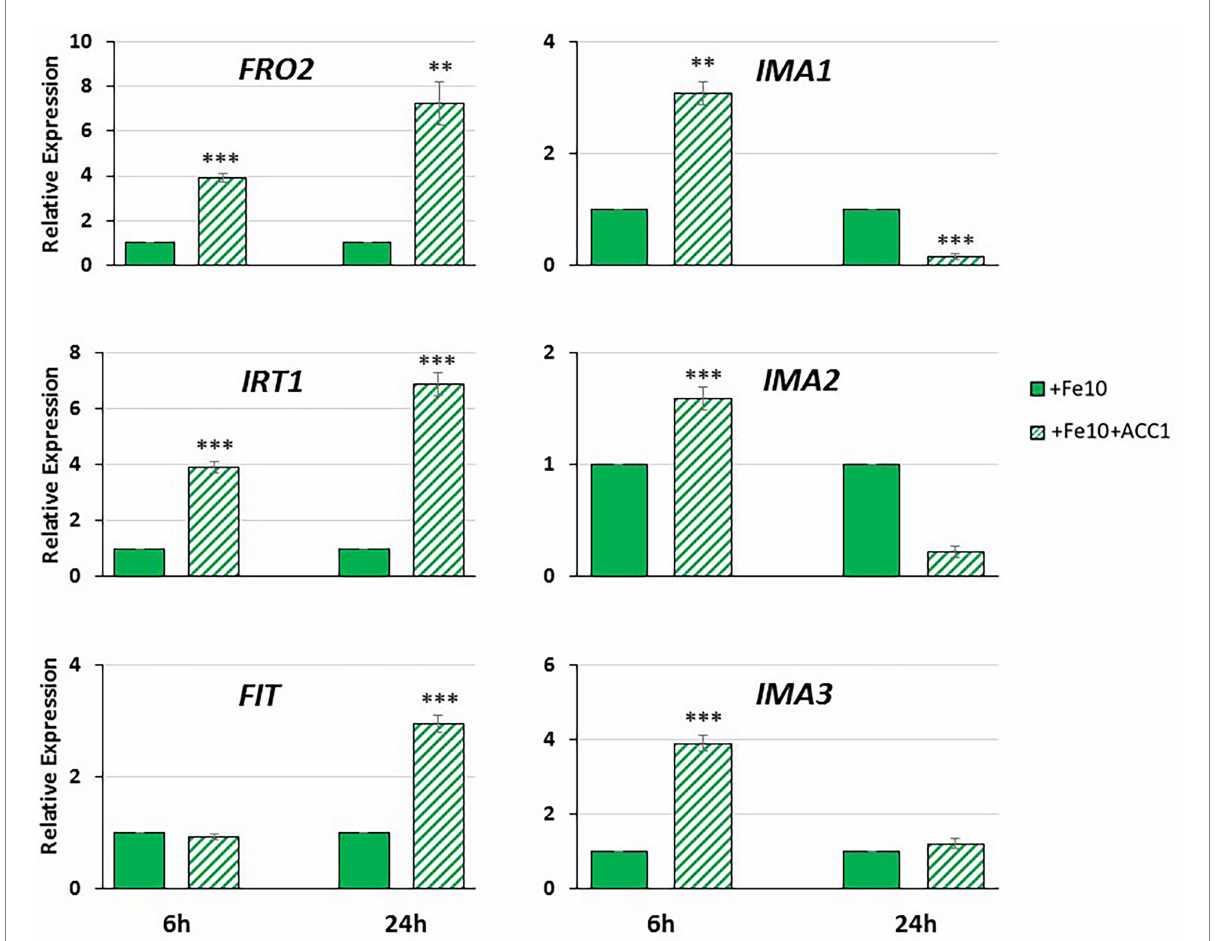
FIGURE 6 Effect of ACC treatment on the expression of the Fe acquisition genes FRO2, IRT1 and FIT , and of the IMA peptide genes IMA1 , IMA2 and IMA3 , in roots of Arabidopsis WT Columbia grown under Fe-sufficient conditions. Plants were grown in complete nutrient solution with 10 μ M Fe-EDDHA (+Fe10). ACC at 1 μ M, final concentration, was added to the nutrient solution of half of the plants during the last 6 h or 24 h. IMA1 , IMA2 and IMA3 expression was determined by qRT-PCR. Relative expression was calculated in relation to the +Fe10 treatment. Data represent the mean of 3 independent biological replicates ± S.E. ** or *** indicates significant differences ( p < 0.01 or p < 0,001, respectively) in relation to their respective control (+Fe10 6 h or + Fe10 24 h), using a Student’s test t